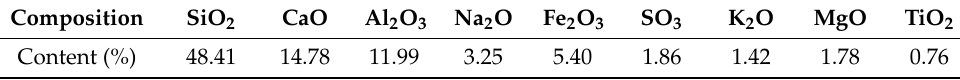
Figure 2. Gradation curve of MSWI powder. Table 1. Chemical composition of MSWI